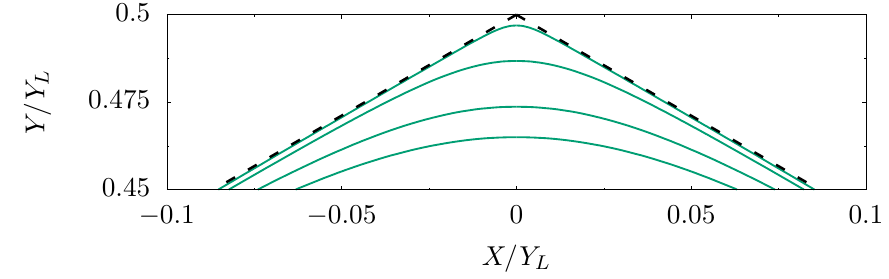
Figure 2 . Local convergence towards the double-cone horizon shape. We embed the horizons of di(cid:11)erent localized black holes solutions into nine-dimensional (cid:13)at space and display two-dimensional cross-sections disregarding the seven-dimensional spherical symmetry. The non-trivial directions X and Y correspond to our spacetime coordinates x and y . In the region close to the edge of the compact dimension, Y . Y L = 2, we see that the shape predicted by the double-cone metric (dashed line) is nicely approached by localized black hole horizons (green lines) for increasing mass or decreasing temperature,